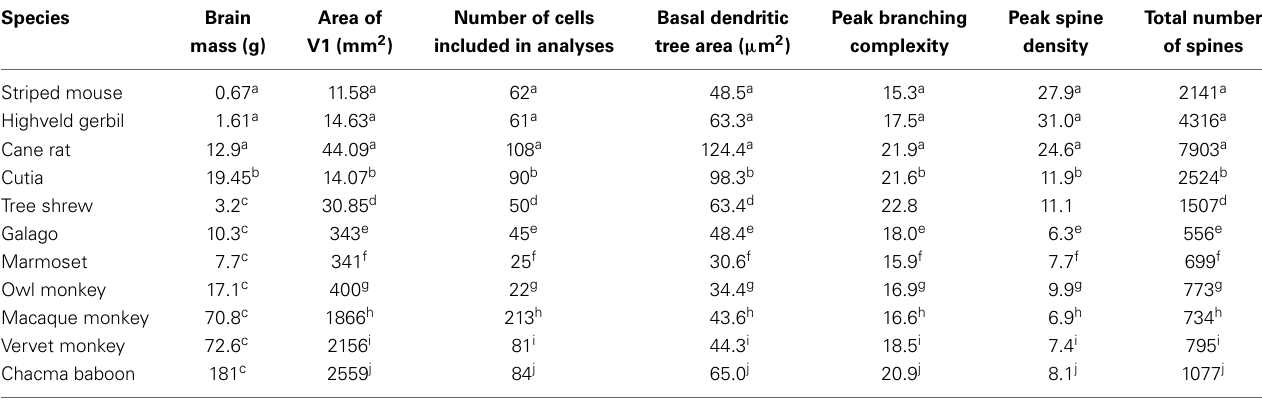
Table 1 | Data on the size of the brain and V1, and the size, branching complexity, spine density, and total number of spines in the dendritic trees of layer III pyramidal cells in species included in the present